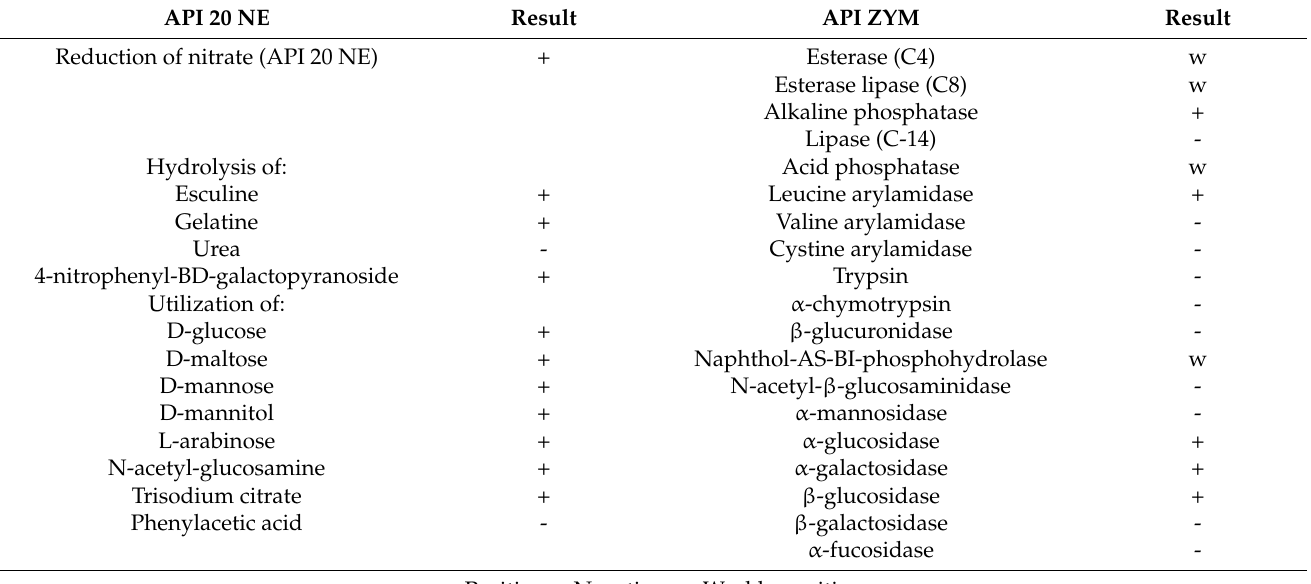
Table 1. Biochemical characterization of Bacillus sonorensis